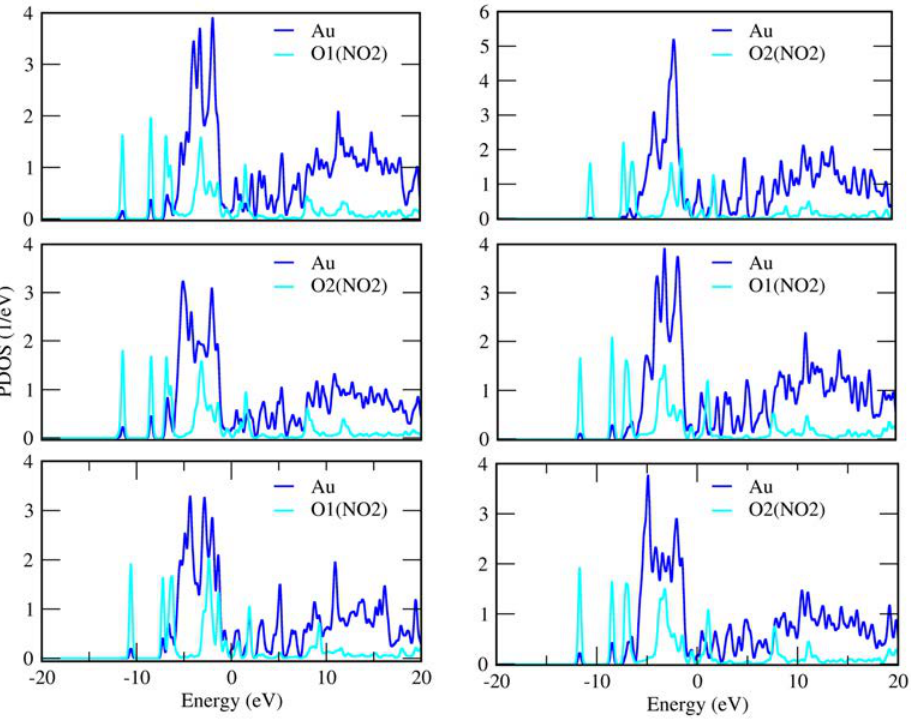
Fig. 9. PDOS for the adsorption complexes of TiO complex; d: B complex; e: C complex; f: C